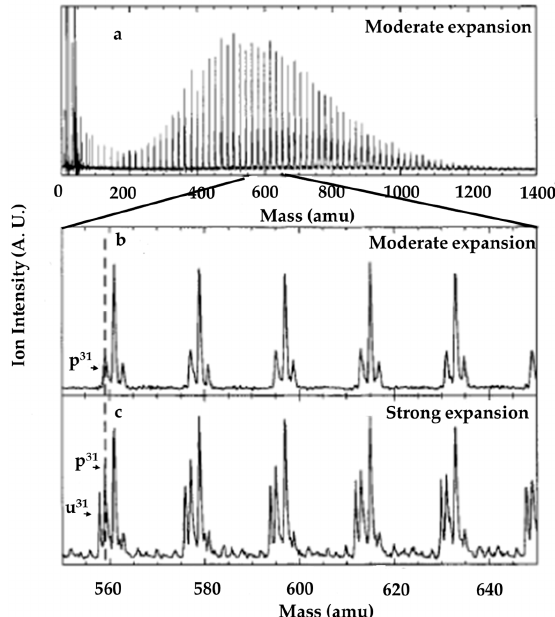
Figure 12. Molecular beam photoionization reflectron TOF mass spectrometer detected by Jongma et al. ( a ) Mass spectrum as recorded using a weak H 2 O / Ar expansion. ( b ) Small part of the same spectrum as displayed in ( a ), starting at p 31 . A progression of “triplets” separated by 18 amu is clearly seen. The first peak of each group is the parent p n ion for n = 31–36. The second and third peaks are daughter ion peaks, produced by the loss of one and two water monomers from the protonated parent ion, respectively. ( c ) Mass spectrum recorded under strong expansion conditions. An extra peak with a mass that is 1 amu less than that of the p n parent is observed and assigned as the “unprotonated” water cluster. The small peaks between the quartets are the same unprotonated ions with varying numbers of Ar atoms attached to them. Figure adapted from [48] with permission. Copyright 1998 American Chemical